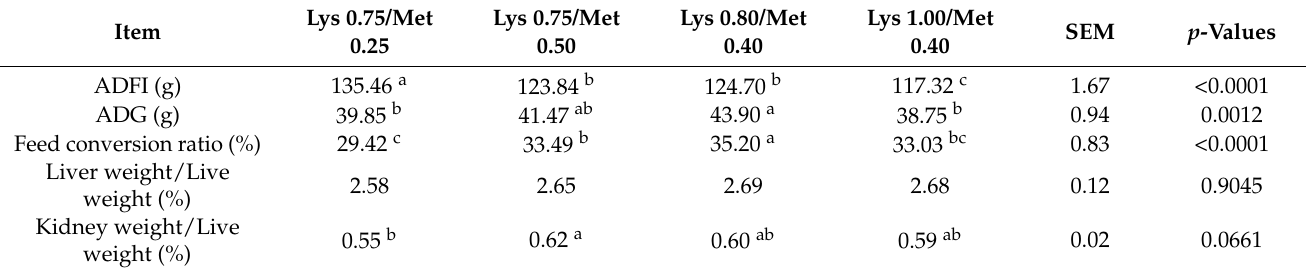
Table 1. Effects of different lysine and methionine composition in the diet on the production perfor- mance of rabbits ( n = 30).